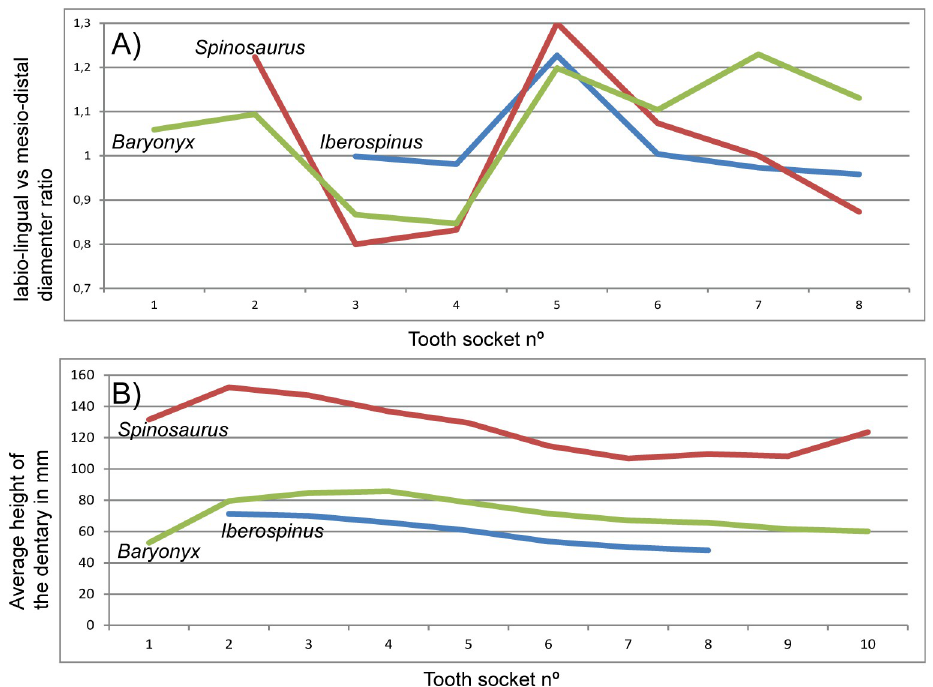
Fig 26. Graphical comparison of the holotype of Iberospinus natarioi (ML1190-1) with Spinosaurus and Baryonyx dentaries. A , ratio between labio-lingual and mesio-distal diameters of teeth sockets in the dentaries of ML1190-1, Baryonyx holotype (NHMUK VP R9951), and a dentary attributed to Spinosaurus (NHMUK VP 16421); B , average of lateral and lingual dorsoventral heights of the dentary for each teeth socket of ML1190-1, Baryonyx holotype (NHMUK VP R9951) and a dentary attributed to Spinosaurus (NHMUK VP 16421); measurements are in mm. spinosaurids of Kem Kem, with medium to high values in PC1 and medium to low values in PC2; and 3) Tyrannotitan isolated with high values in both PC1 and PC2. This scenario does not change when the midlength diameters of the unguals are included. ML1190-34 is thus most morphometrically similar to the ungual phalanx of the fifth digit of FSAC-KK 11888. MPCM 13574 , Spinosaurus ungual phalanx, black dot; FSAC-KK18888 , relatively complete foot of Spinosaurus , inverted blue triangle; UCMP 37302 , Dilophosaurus , orange squares; MPEF-PV1157 , Tyrannotitan ungual phalanx, violet dot; MPCM 13573 , Abelisauridae indet. ungual phalanx, green inverted triangle.